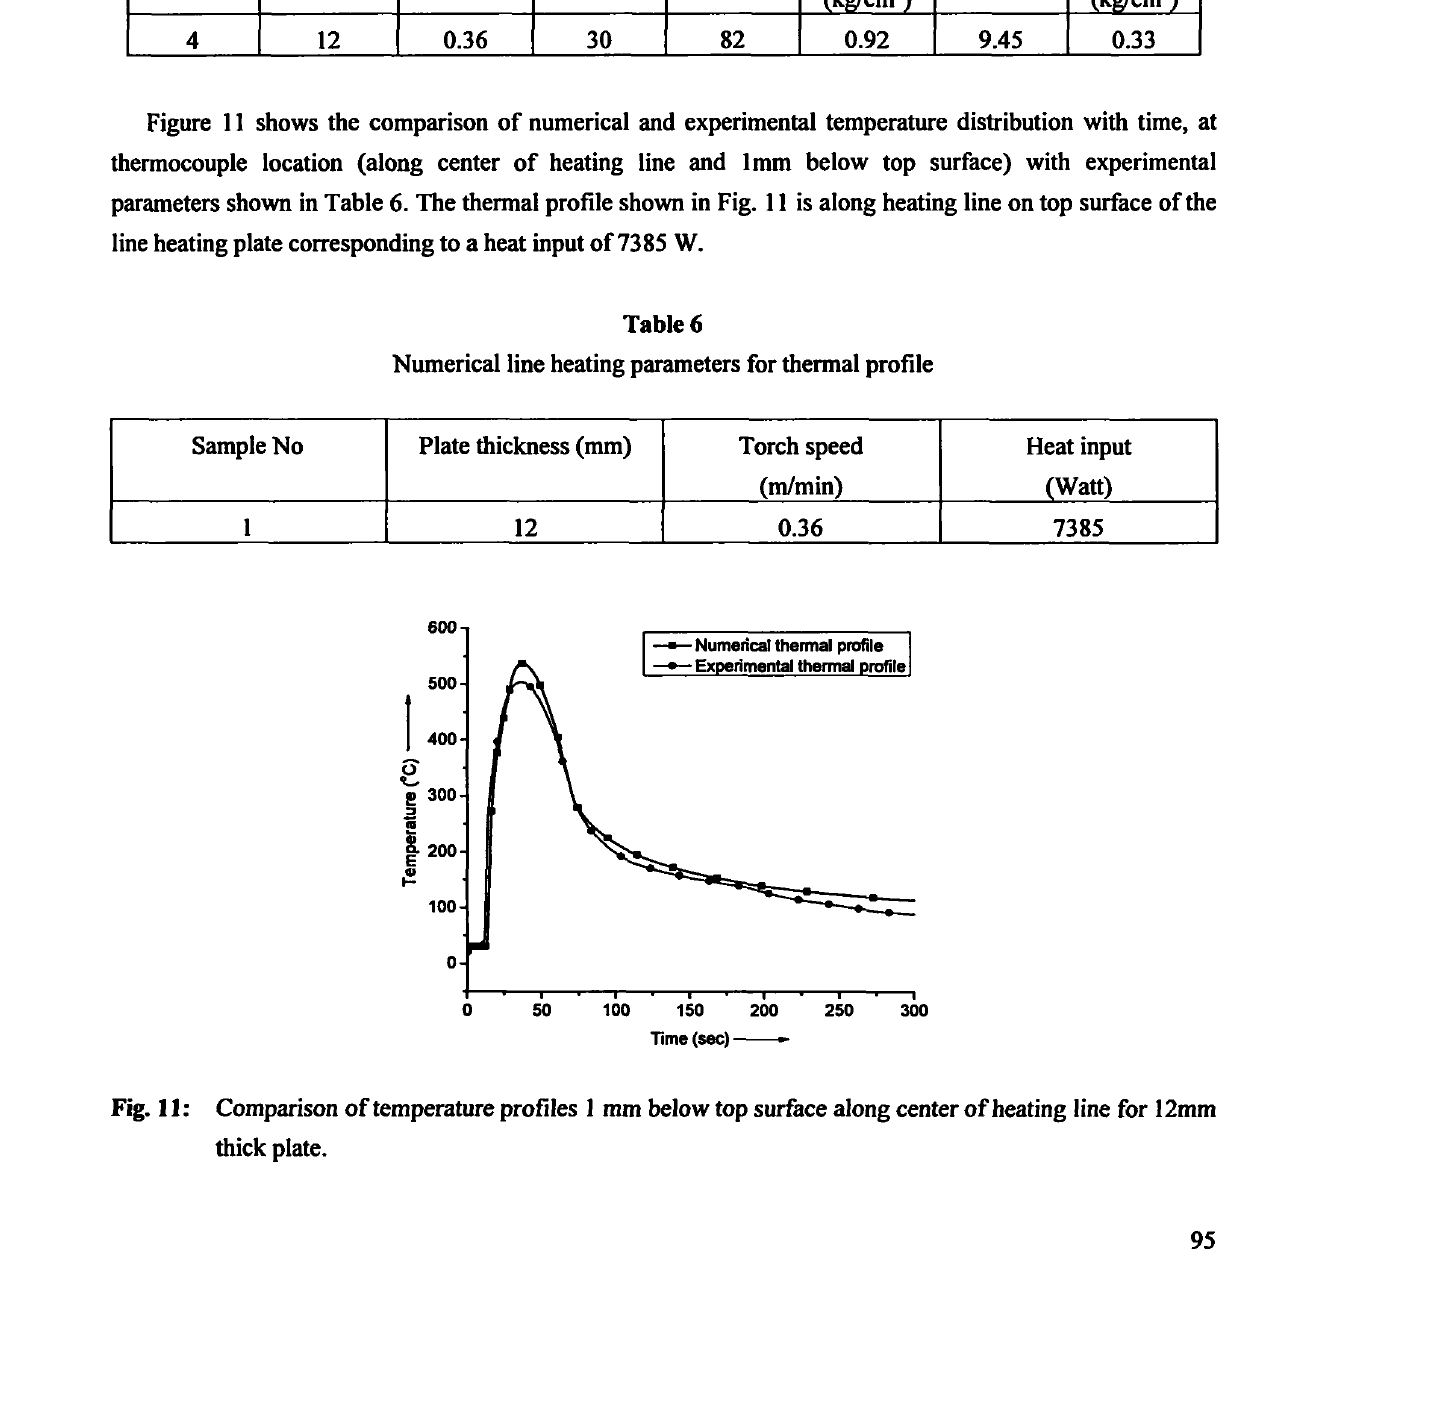
Fig. 11: Comparison of temperature profiles 1 mm below top surface along center of heating line for 12mm thick